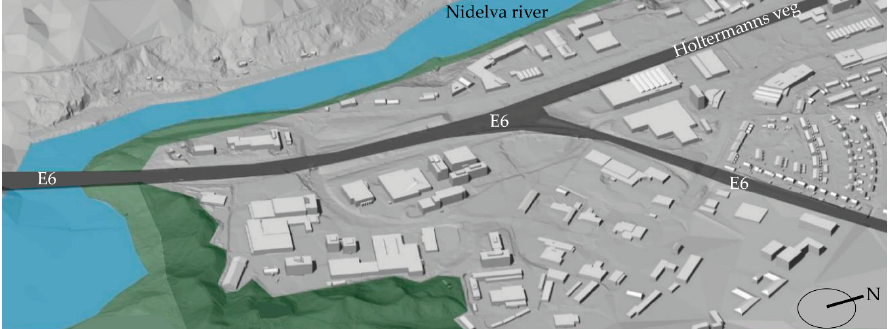
Figure 1. Overview of the Sluppen area.